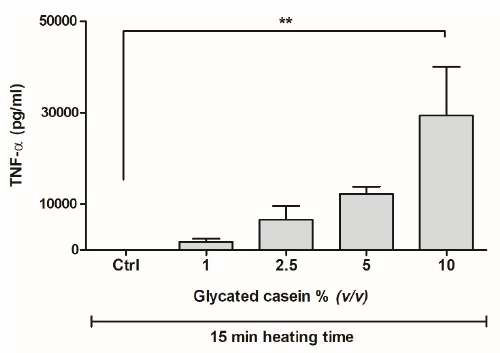
Figure 3. TNF- α secretion of human macrophage-like cells after 6 h exposure to different concentrations of glycated casein heated for 15 min measured by ELISA. Data are presented as mean ± SD, n = 3, ** = p < 0.01.